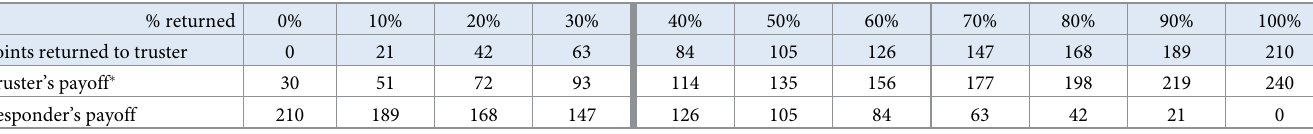
Table 1. Payoffs as a function of percent returned by the responder. %